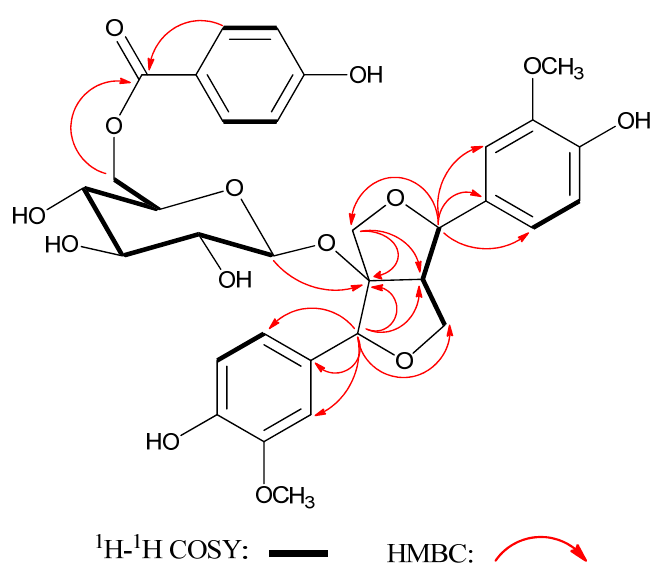
Figure 2. Key 1 H- 1 H COSY and HMBC correlations of compound 1